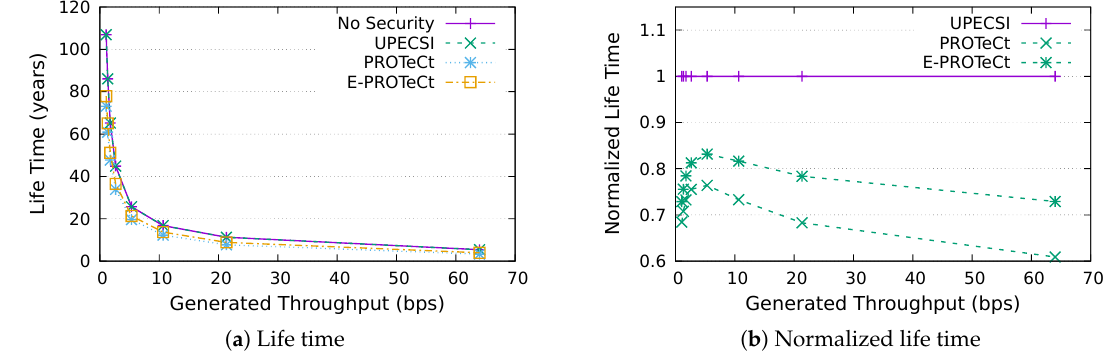
Figure 18. Life time analysis for an IoT network with four devices.